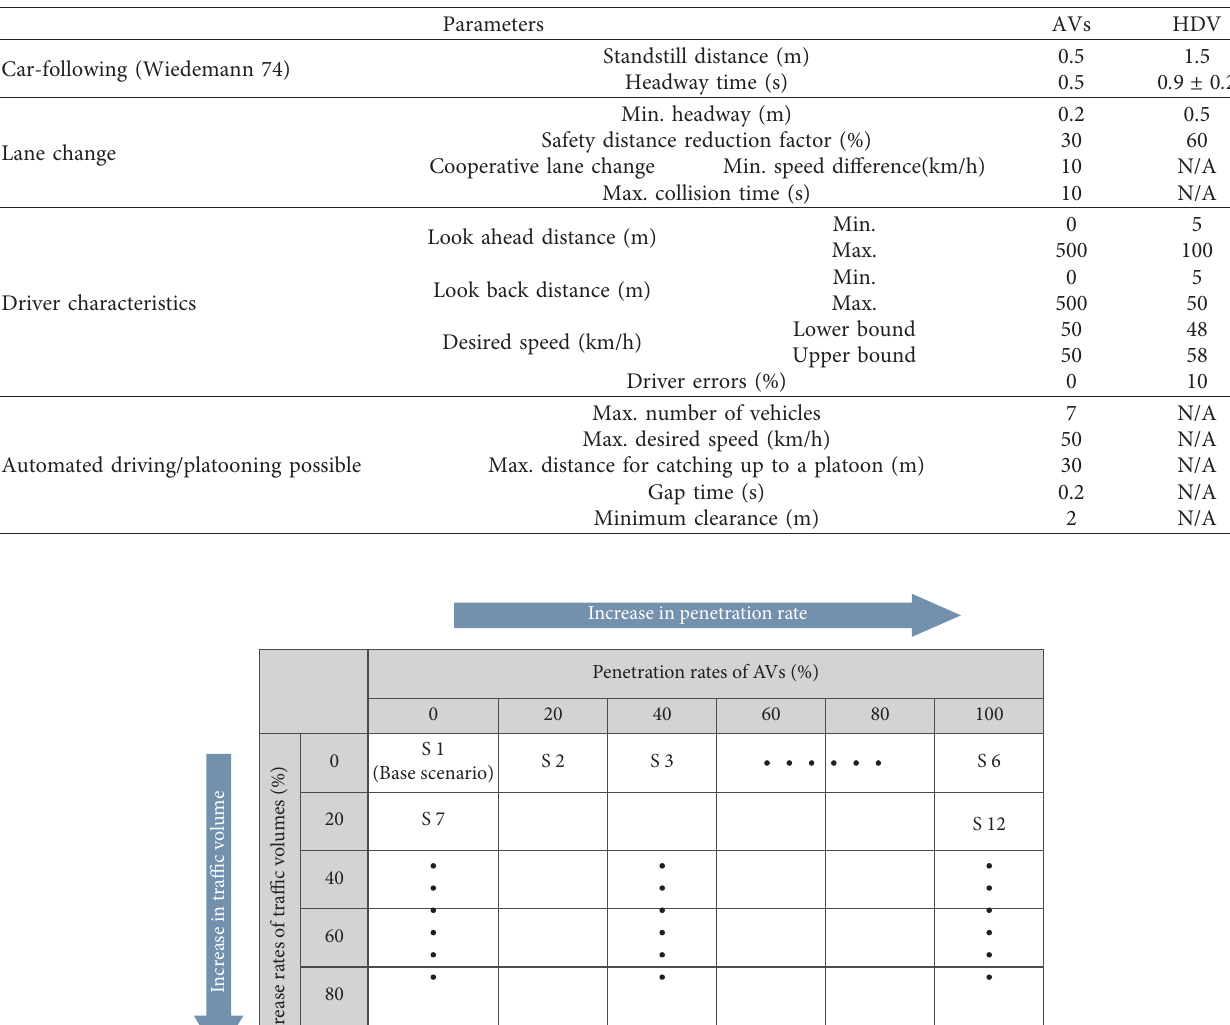
Figure 2: Scenario matrix.